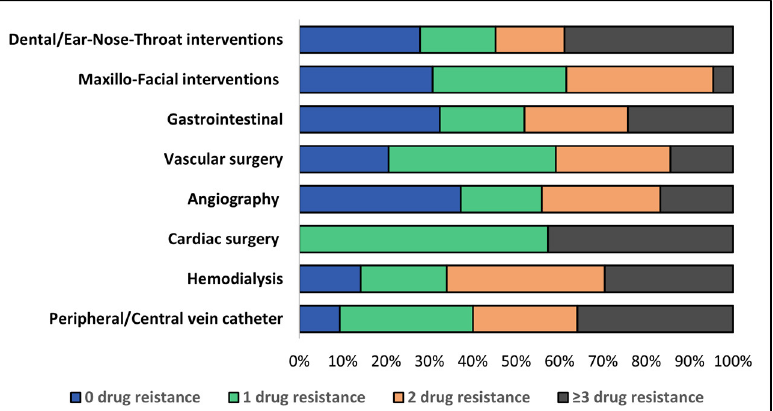
Figure 5. Stacked bar representation of antimicrobial resistance by the source of infection.